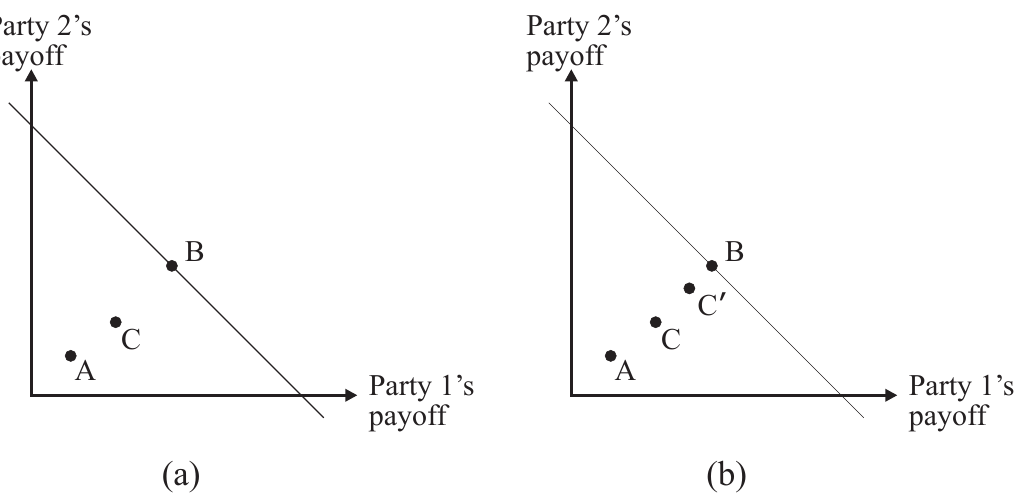
Figure 1. Renegotiation in payoff space for a given